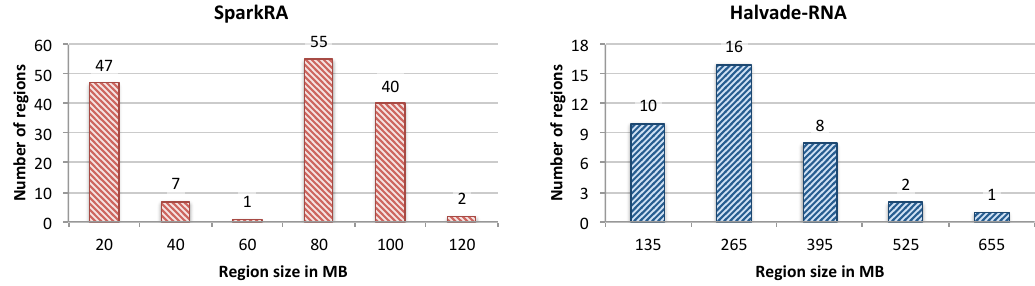
Figure 5. Histogram of the size of regions (in MB) generated by SparkRA ( left ) and Halvade-RNA ( right